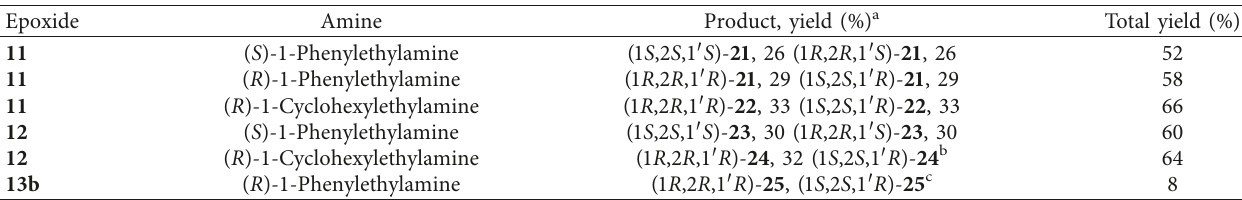
Table 1: Ring opening of 2-oxiranyl-azaarenes with chiral amines.